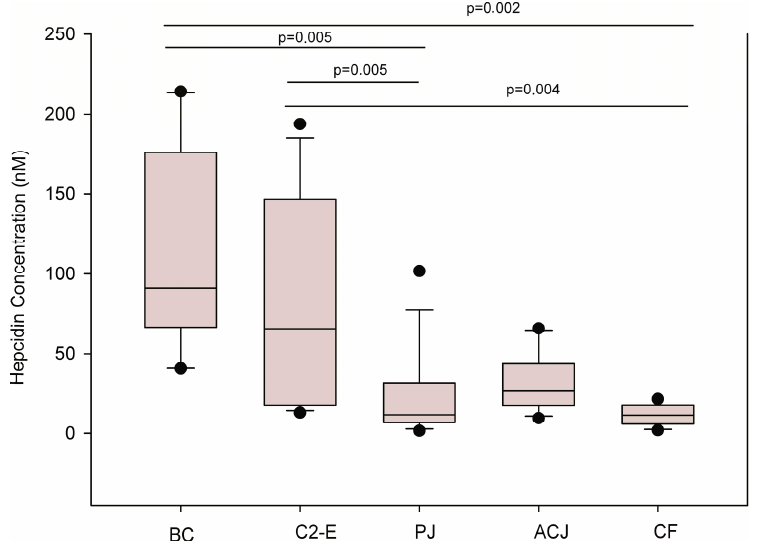
Figure 2. Hepcidin levels (nM) determined in plasma samples of triathletes following the training and nutritional intervention program. Box plots with quartiles (upper values, 75%; median, 50%; and lower values, 25%). Friedman ′ s ANOVA and post hoc analysis with Wilcoxon signed-rank tests (with a Bonferroni correction) were conducted ( p < 0.005).